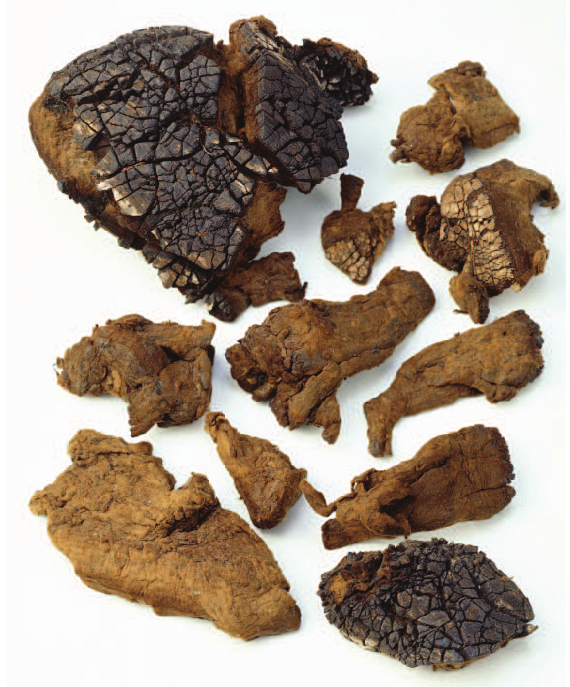
Fig. 1. Fragments of tinder carried by the Ice man. Pho- to Augustin Ochsenreiter, Fotoarchivio Museo Archeo- logico dell’Alto Adige, Bolzano, Italy (www.iceman.it).